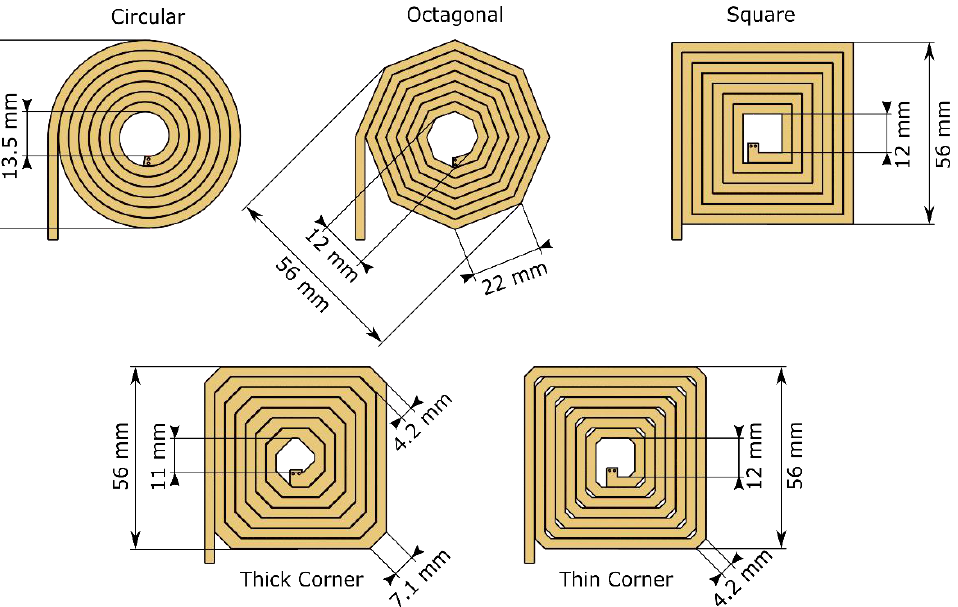
Figure 2. Different coil geometries with dimensions: Square, Circular, Octagonal, Square with beveled corners constant trace spacing (Thick Corner), Square with beveled corners constant trace width (Thin Corner).